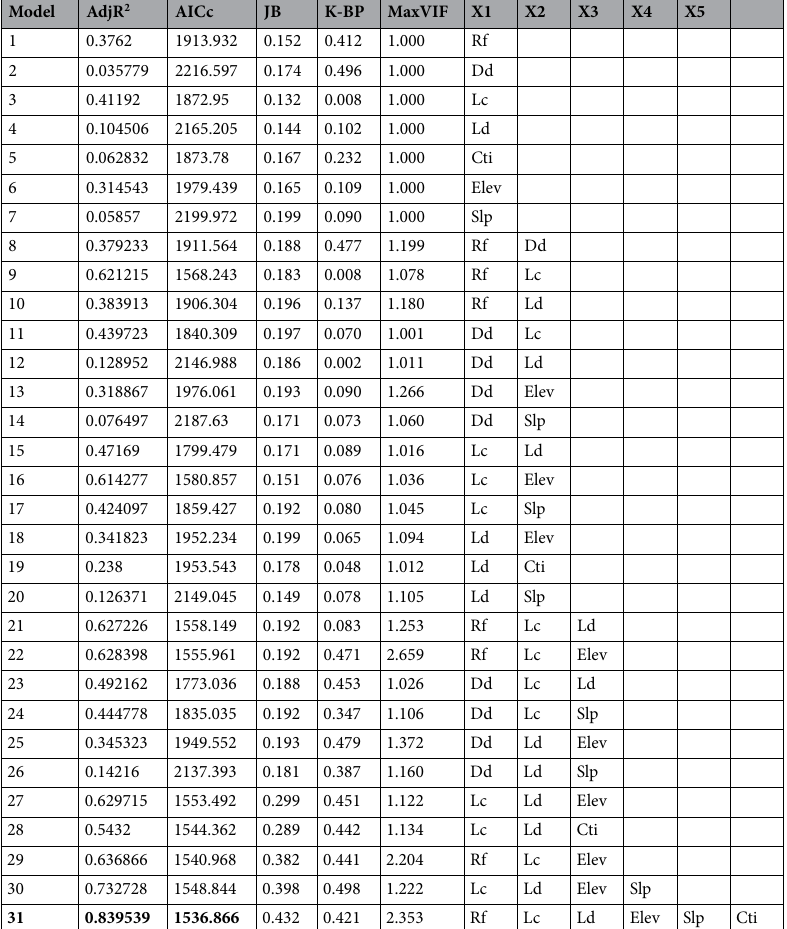
Table 3. Exploratory regression models. Significant values are in bold. Where, AdjR 2 Adjusted R squared, AICc Akaike’s information criterion, JB Jarque-Bera statistic, K-BP Koenker (BP) statistic, MaxVIF Maximum Variance Inflation, X variables. Rf rainfall, Dd drainage density, Lc landcover, Ld lineament density, Elev elevation, Slp slope, Cti compound topography index. Measures of model performance. When this test is statistically significant (p < 0.01) model predictions are biased (the residuals are not normally distributed). When this test is statistically significant (p < 0.01), the relationships modeled are not consistent (either due to non-stationarity or heteroskedasticity). Large VIF (> 7.5, for example) indicates explanatory variable